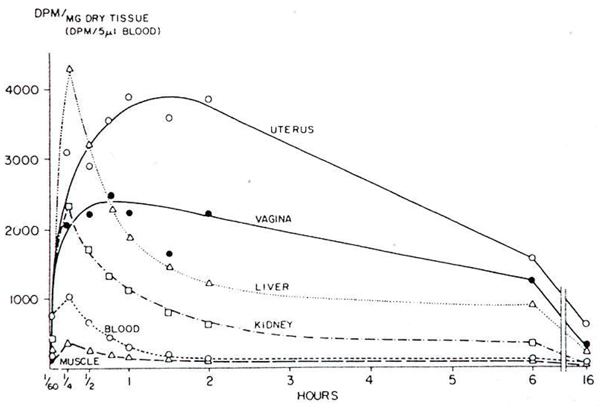
Tritiated estradiol was used as a tracer by Jensen and Jacobsen to study in vivo uptake and retention in the rat [20]. This classic study helped to establish the presence of estrogen receptors in target tissues.